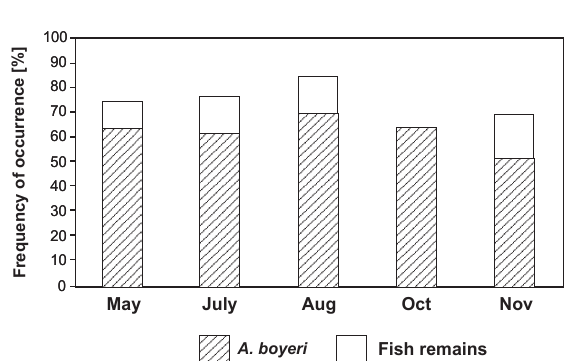
Figure 3. The frequency of occurrence of unidentified fish re - mains and Atherina boyeri found in the gut contents of the Scar- dinius acarnanicus specimens taken from Lake Trichonis using light between May and November 2017.